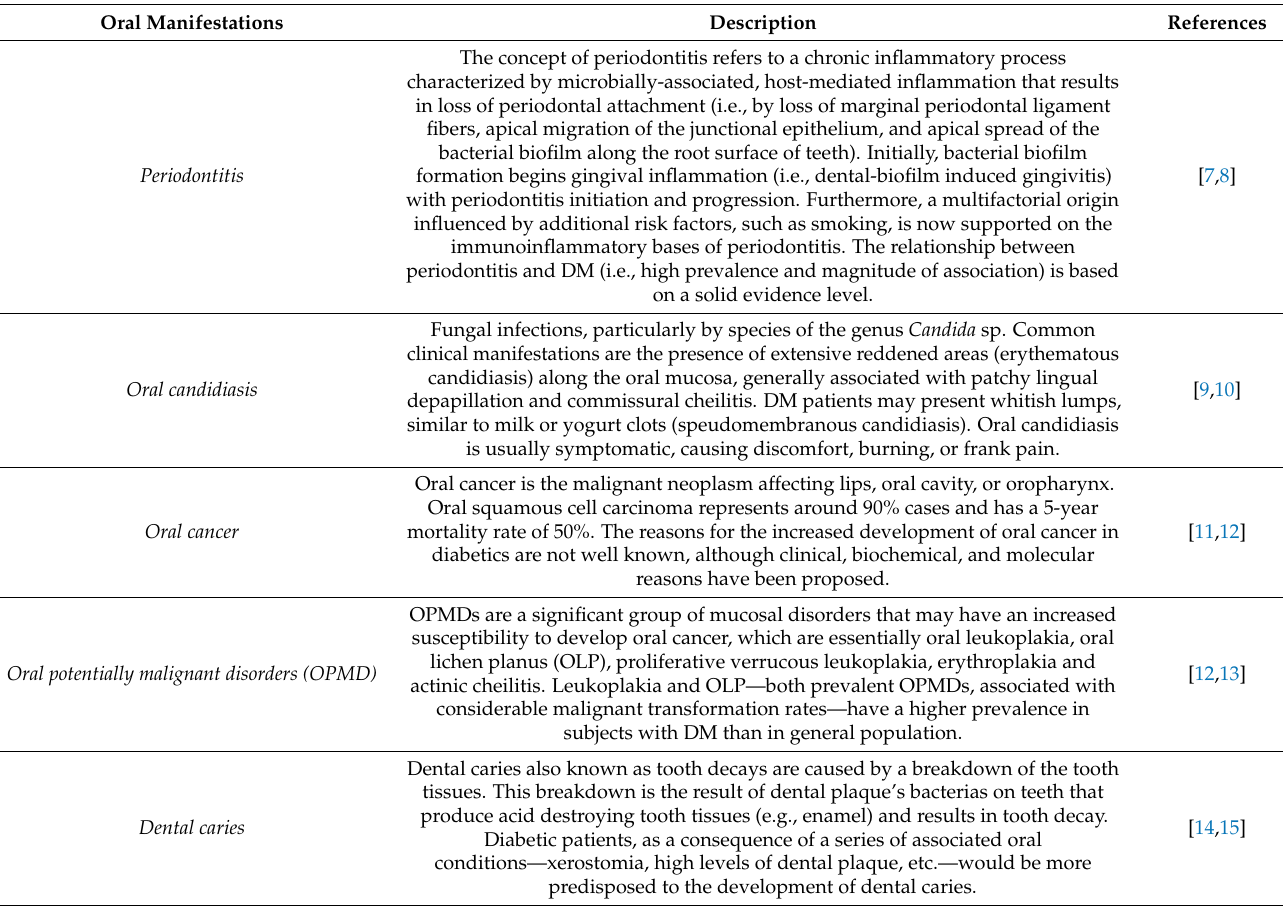
Table 1. Oral manifestations that may be present in patients with Diabetes